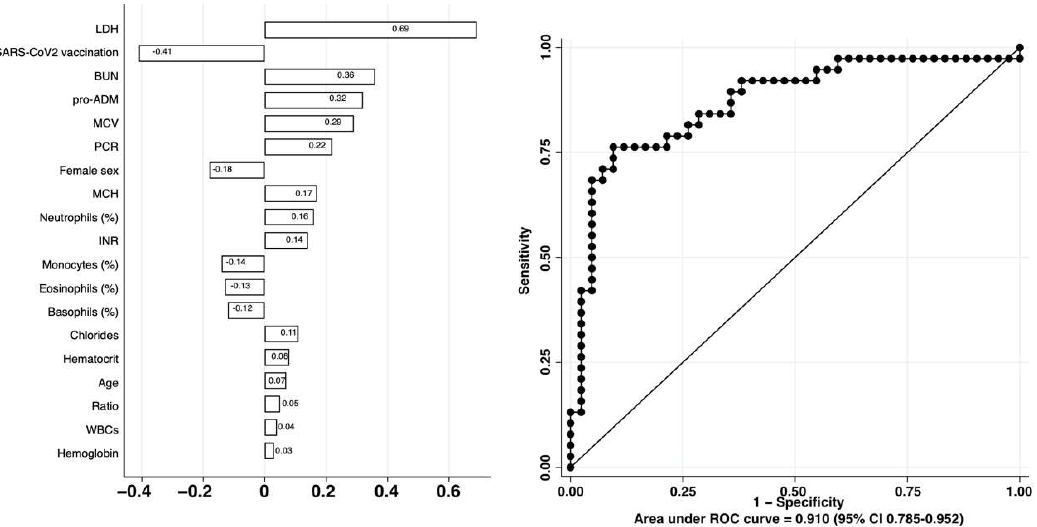
Figure 1. Elastic net logistic regression with hematochemical variables. Receiver Operating Characteristic (ROC), Area Under the Curve (AUC) with its 95% confidence interval (CI) are 0.868 (95% CI 0.785–0.952).